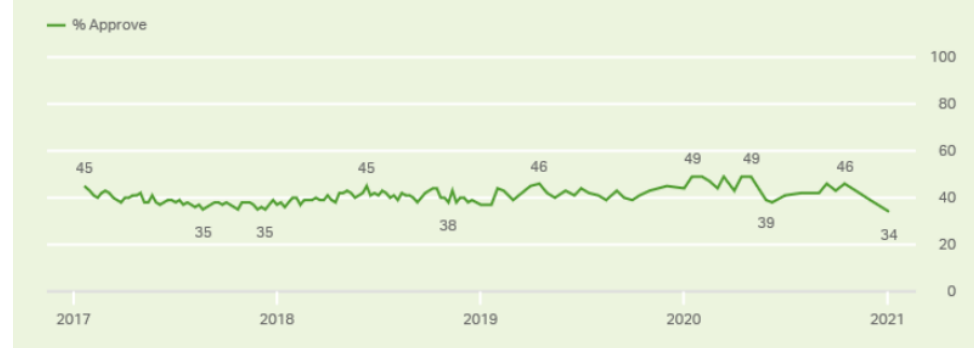
Figure 1. President Donald Trump’s Job Approval Ratings, Full Trend. Source: (Gallup Poll 2021).